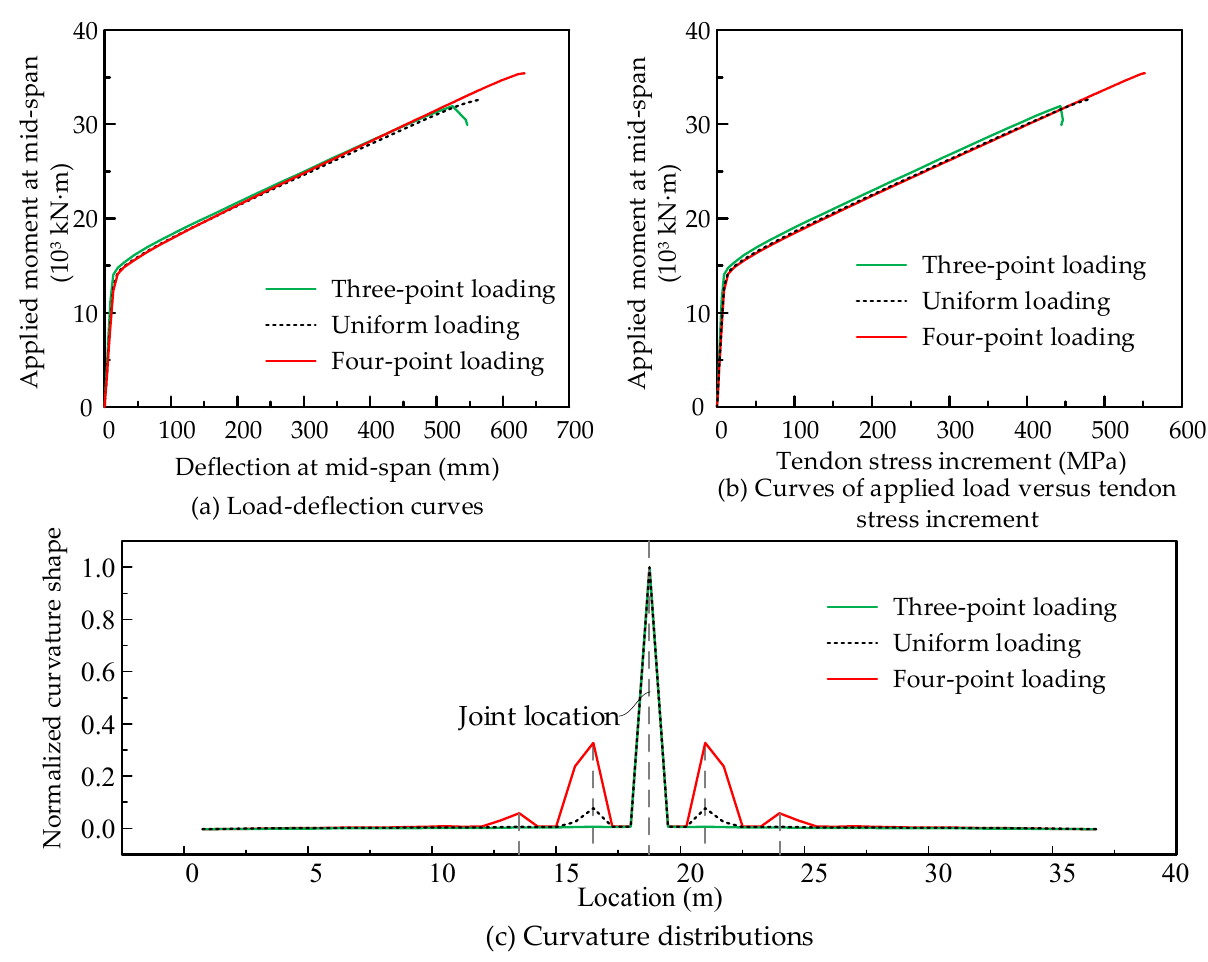
Figure 15. Effects of loading types on the flexural behaviors of PSCBIU-CFRP. (2) Span-to-depth ratio L / d p Based on the design details of Beam-2 in Figure 13b, the tendon effective depth d p varies from 2.025 and 2.225 to 1.8 m; then, beams with a span-to-depth ratio L / d p of 16.85, 18.5, and 20.8 are obtained to discuss the effects on the flexural performances. All of the models are applied with three-point loading up to failure and the results are shown in Figure 16. With L / d p increasing by 23%, the flexural capacity decreases by about 38.6% and the tendon stress increment decreases by about 15.7%. This reveals that a smaller span-to-depth ratio L / d p is conducive to flexural performance.